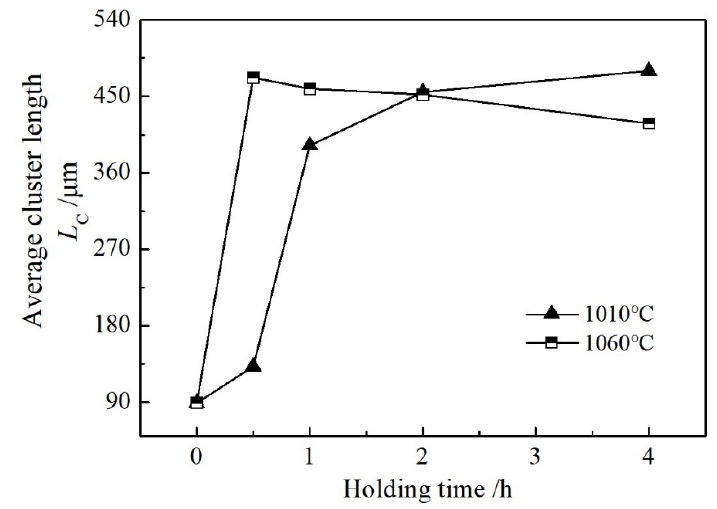
Figure 4. Evolution of the L C with holding time at different solution annealing temperature.